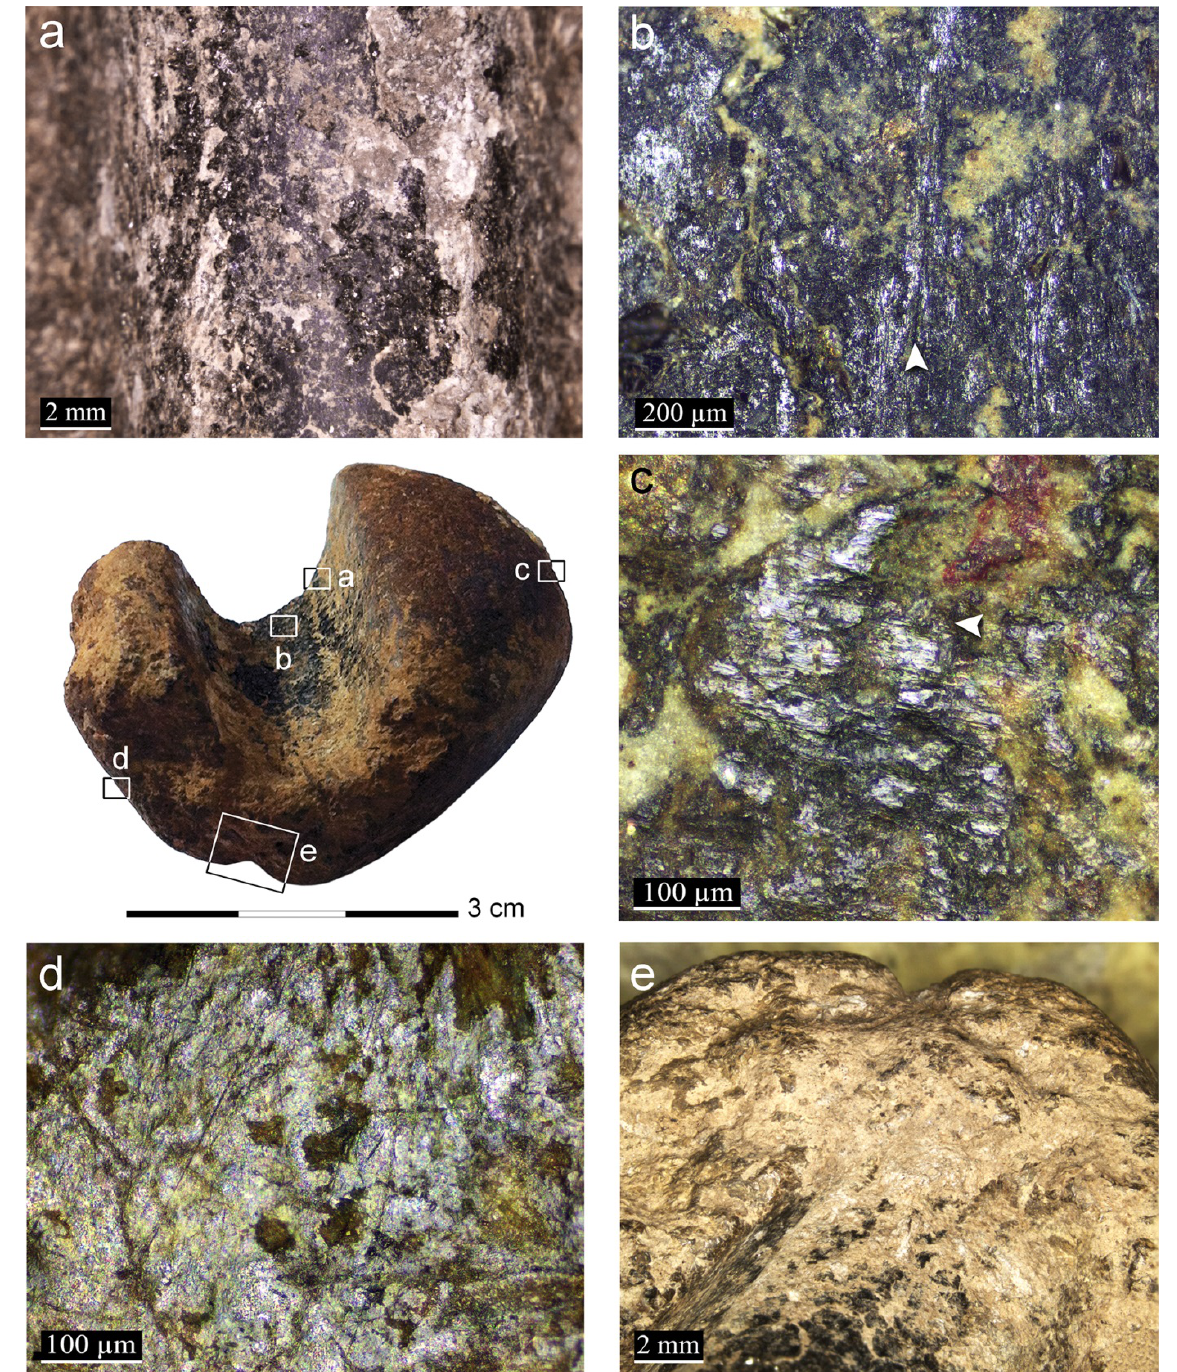
Figure 8: Artefact number 181 showing the concave bottom of the groove and walls extending outward. Locations of microphotographs are indicated by arrows. Traces inside the groove are interpreted as having been produced by contact with a mineral such as sandstone or ochre: a) extreme darkening of the bottom of the groove associated with shallow cracks indicating the application of heat, and flat smooth surface (x6.7), b) thin bright polish with directionality features indicating abrasion along the main axis of the groove, similar to traces observed on experimental basalt abraded against coastal aeolianite ( 'kurkar' ) (see Figure 2g) (x100). Traces on the perimeters interpreted as having been produced by contact with hard stone and by crushing minerals: c) bright, thick polish exhibiting directionality features associated with yellow and red coloured powder (probably ochre) interpreted to be produced by crushing action (x200), d) translucent, thin and dull polish extending over a wide area interpreted to be produced by contact with stone and water (x200), e) area exhibiting cracks and crushing interpreted to be produced by the action of crushing minerals